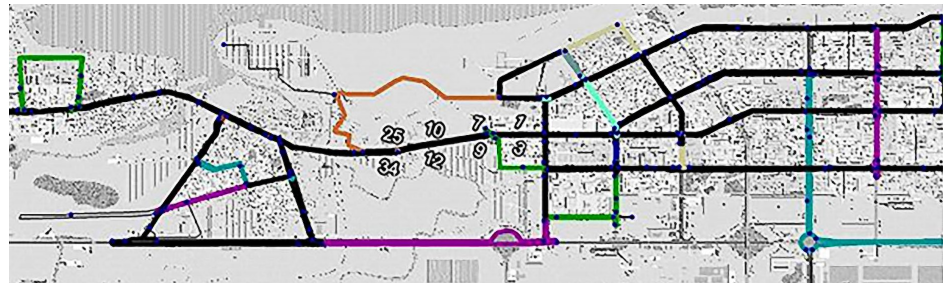
Figure 3. Scheme of the proposed route network